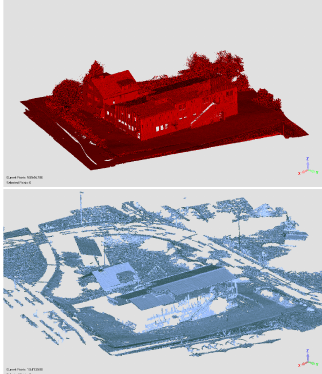
Figure 6: HXE - Top: Laser, Bottom: Photogrammetry